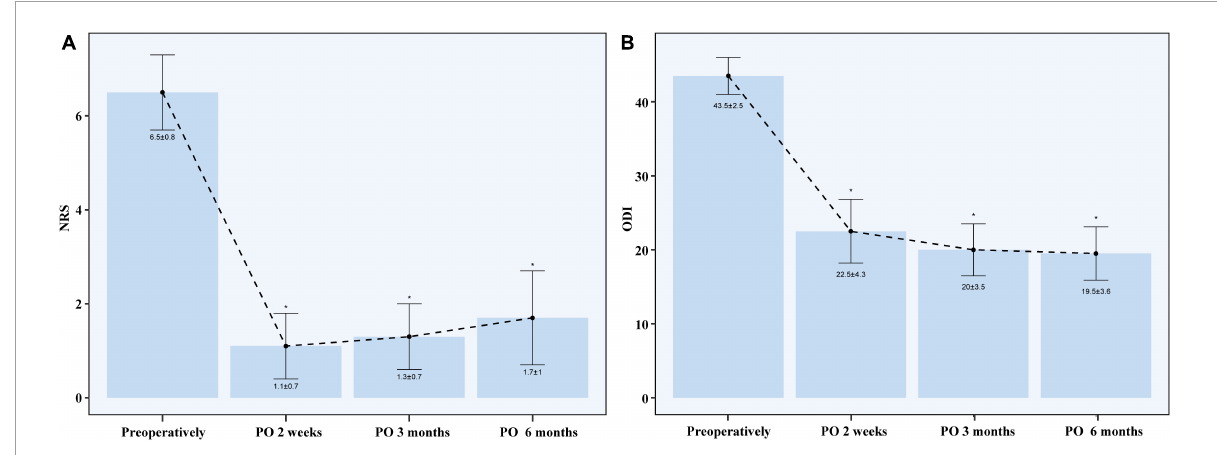
FIGURE2 NRS (A) and ODI (B) after the operation. NRS, numerical rating scale; ODI, Oswestry Disability Index; PO, postoperative. ∗ P value ≤ 0.001 when compared with